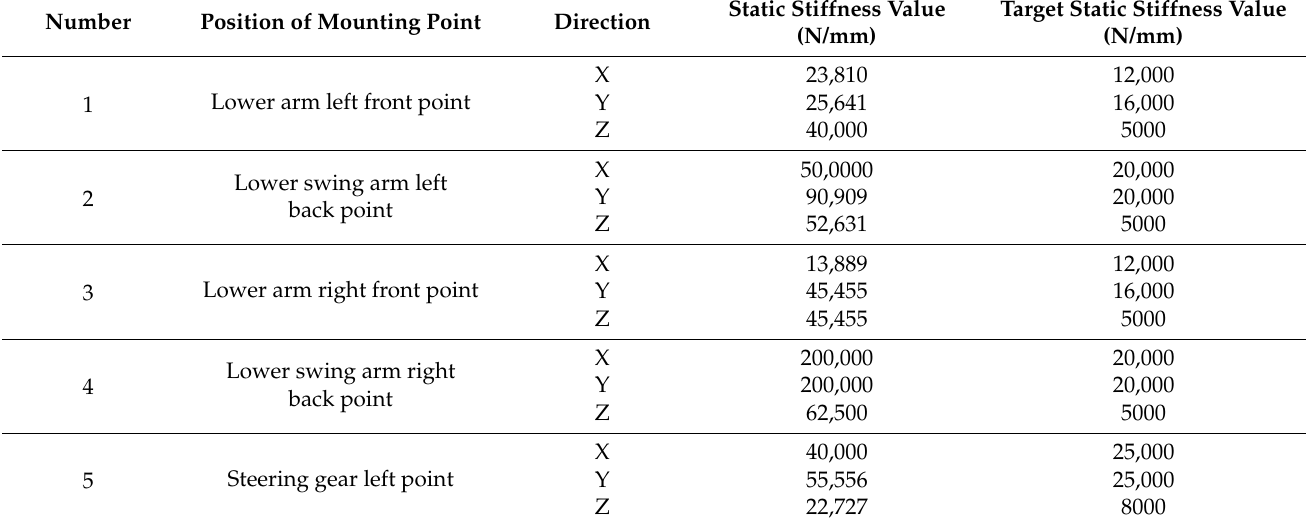
Table 2. Static stiffness analysis results of each mounting point of the aluminium alloy front